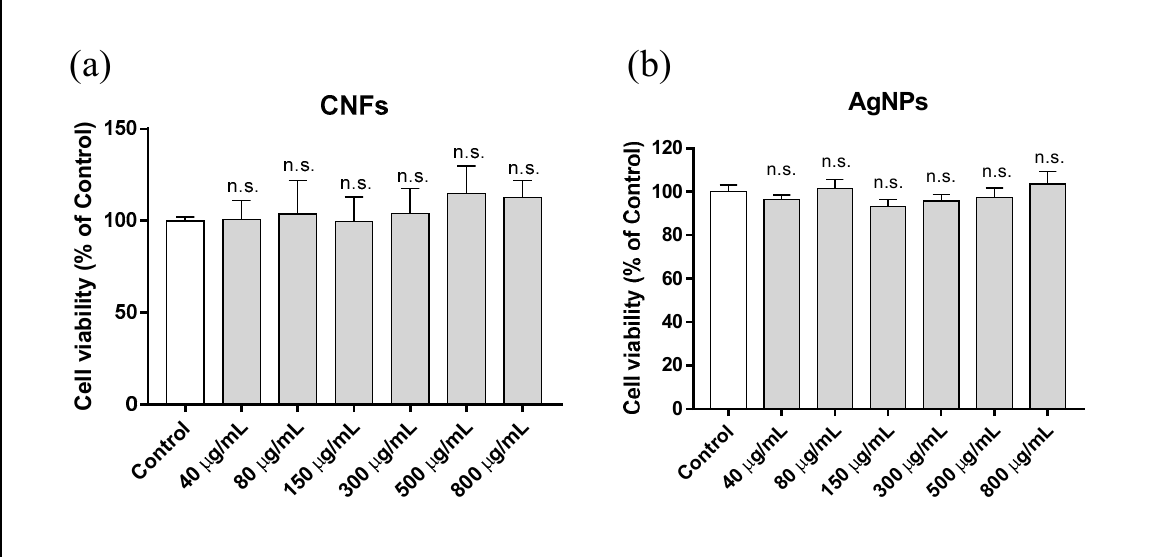
Figure 4. Cytotoxicity assay in human keratinocyte (HaCaT) cells after 3 h exposure to AgNPs ( a ) or CNFs ( b ) at different concentrations ranging from 0 (control) to 800 µg/mL. Cytotoxicity was evaluated by MTT assay. The results are given as a % of the control group. Data are shown as the mean ± standard deviation of six replicates. The ANOVA results of the different AgNP or CNF concentrations with respect to the control are indicated in the plot; n.s: not significant.